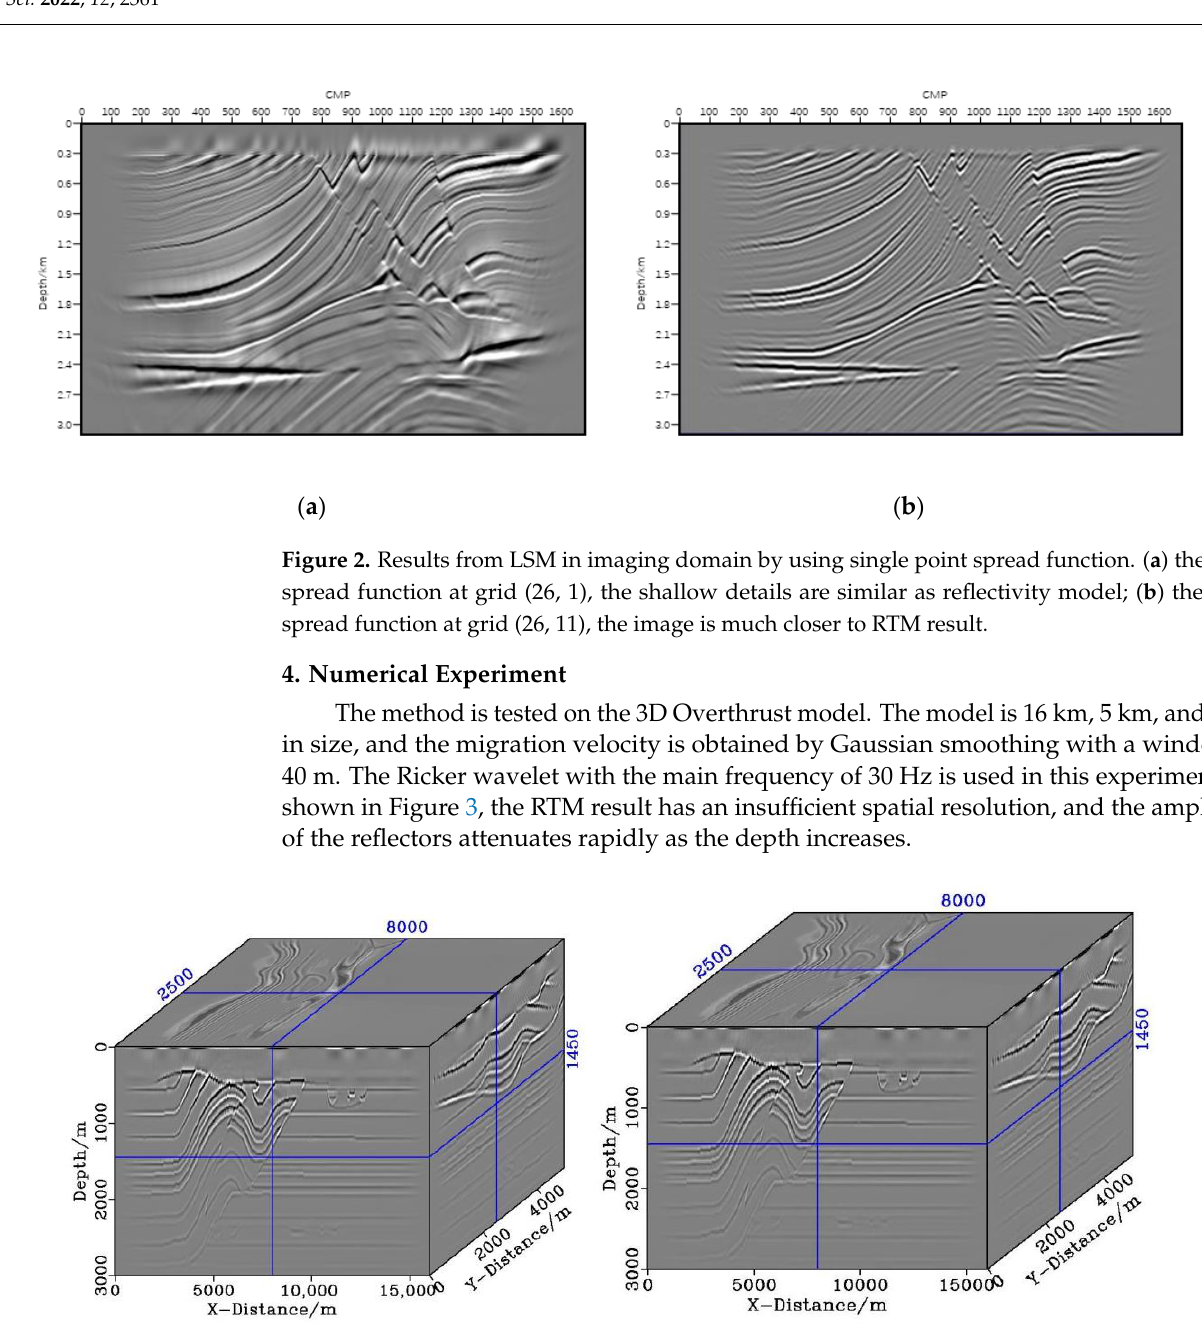
Figure 3. The 3D data volume of RTM in the 3D Overthrust model.